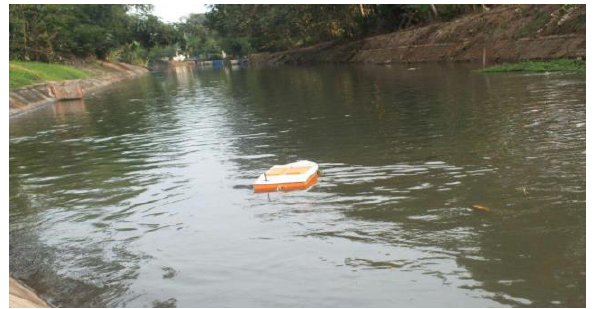
Figure 10. The study area, Anyar River.